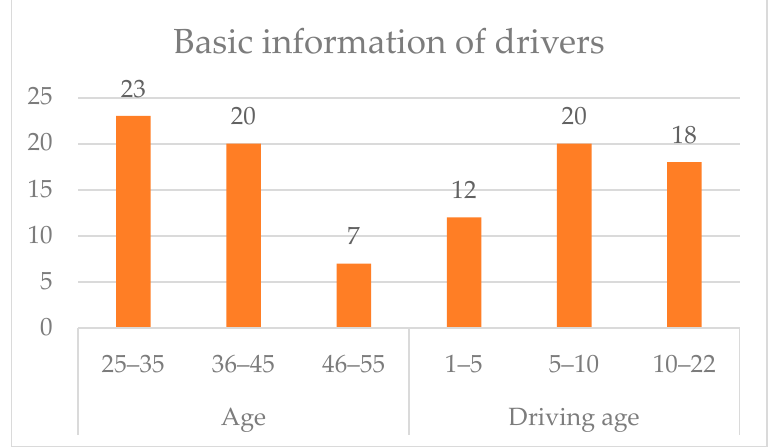
Figure 1. Basic information of the drivers.